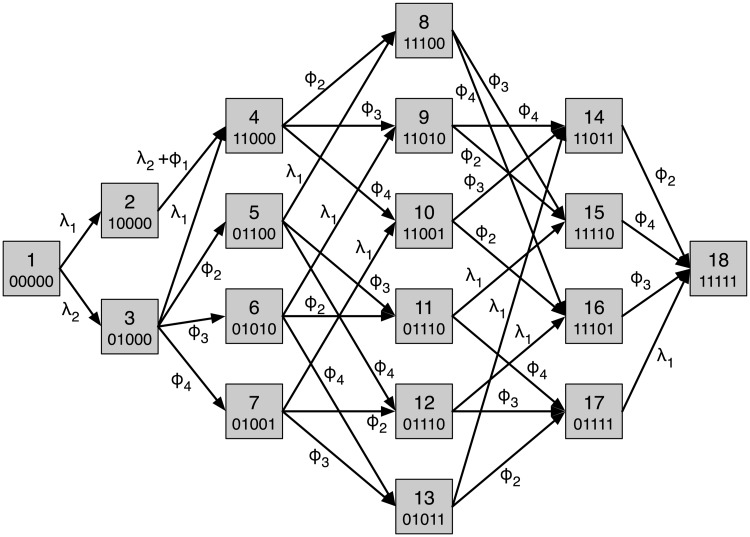
The state transition diagram for the ovarian cancer model.Each node corresponds to a possible metastatic state and is represented by a binary string which signifies which organ is positive or negative for metastases. For convenience the nodes are named from 1 to 18. The rates are obtained from the flow rates in the anatomic network (Fig 3) by considering the rate at which individual sites become positive based on the state of the other sites.